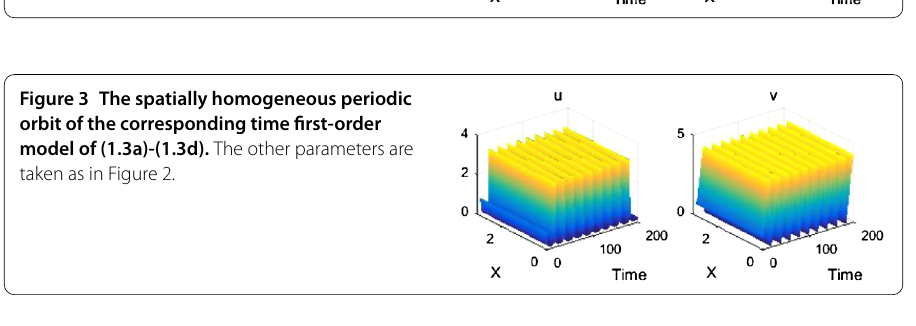
Figure 3 The spatially homogeneous periodic orbit of the corresponding time first-order model of (1.3a)-(1.3d). The other parameters are taken as in Figure 2.